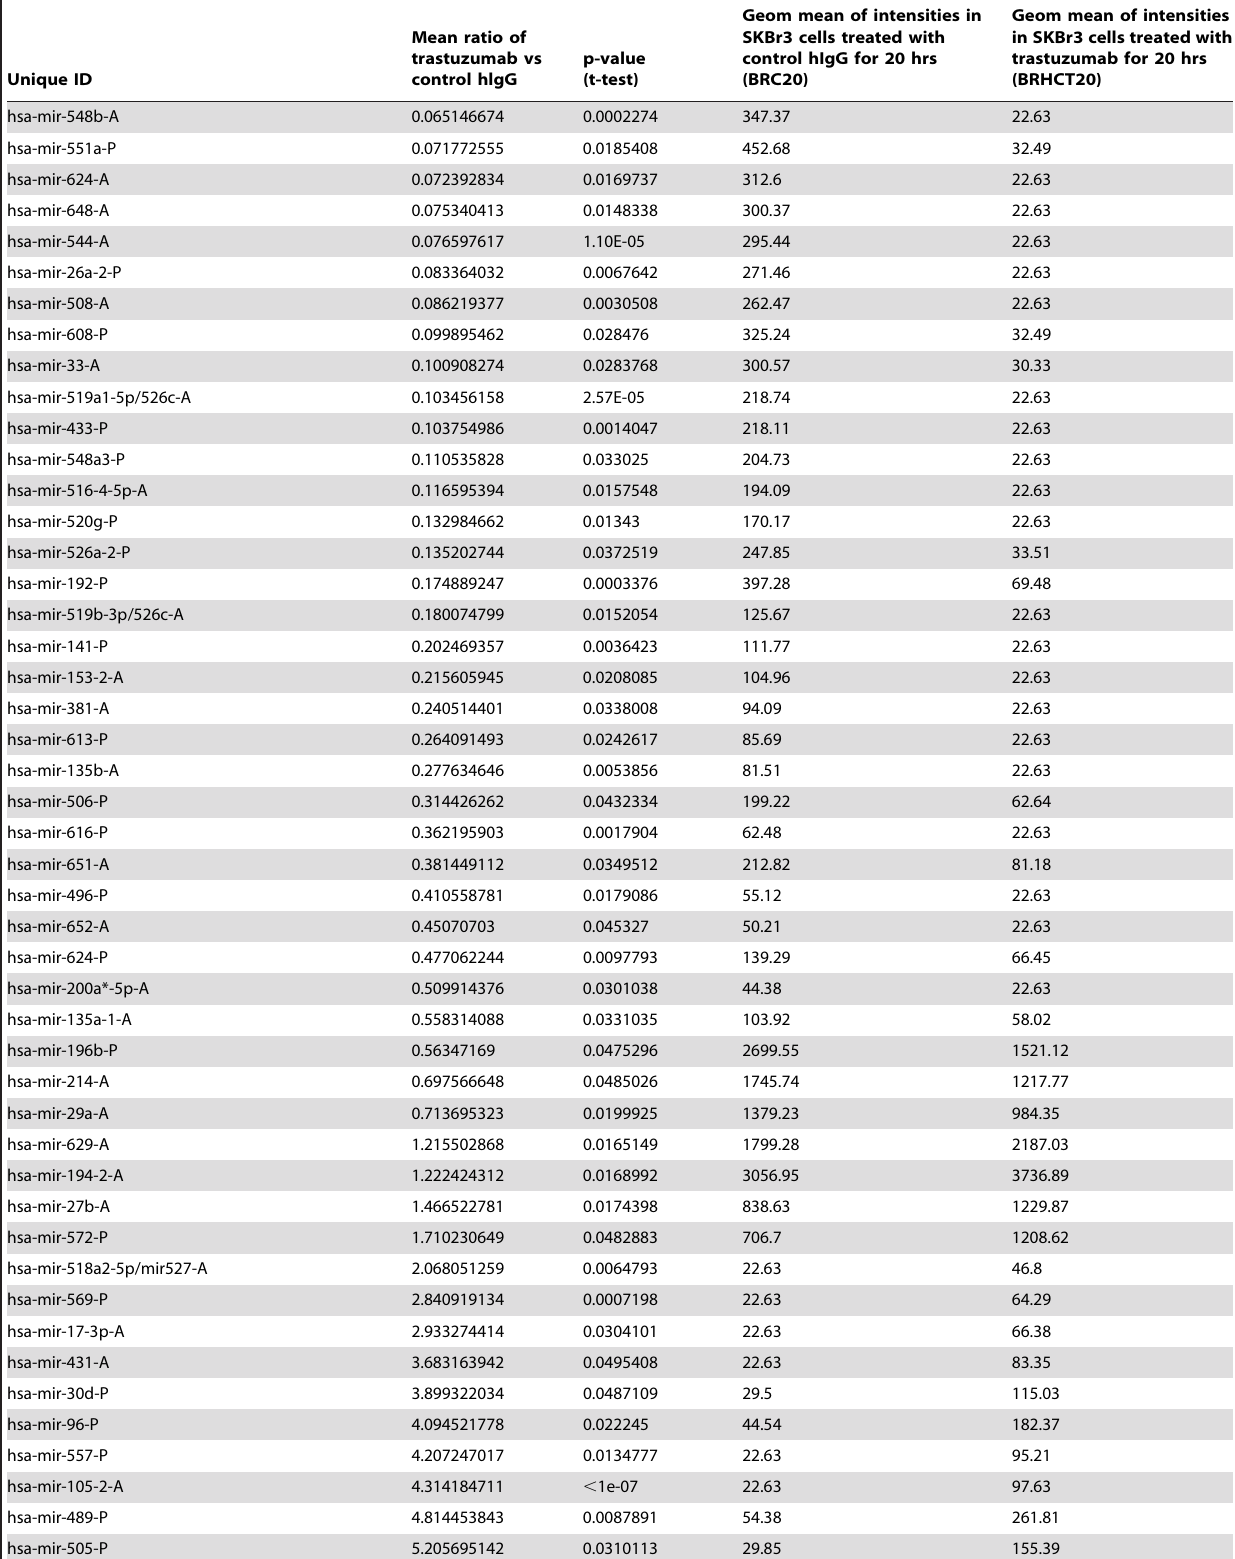
Table 1. miRNAs affected by trastuzumab in SKBr3 cells.